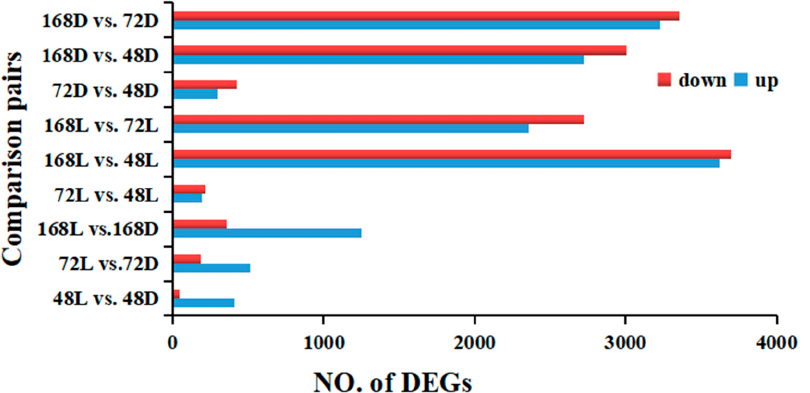
Figure 4. Number of DEGs in samples treated with different light treatments on the peel of peppers.